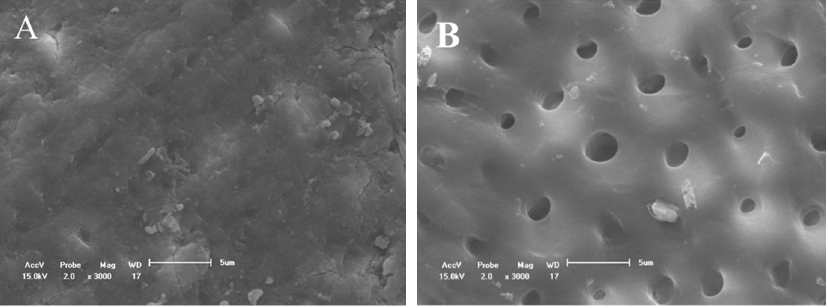
Figure 2. SEM micrographs of the dentine surface morphology at 3000× magnification. ( A ) With smear layer and ( B ) without smear layer. The exposition of dentinal tubules occurred after acid challenge ( B ).